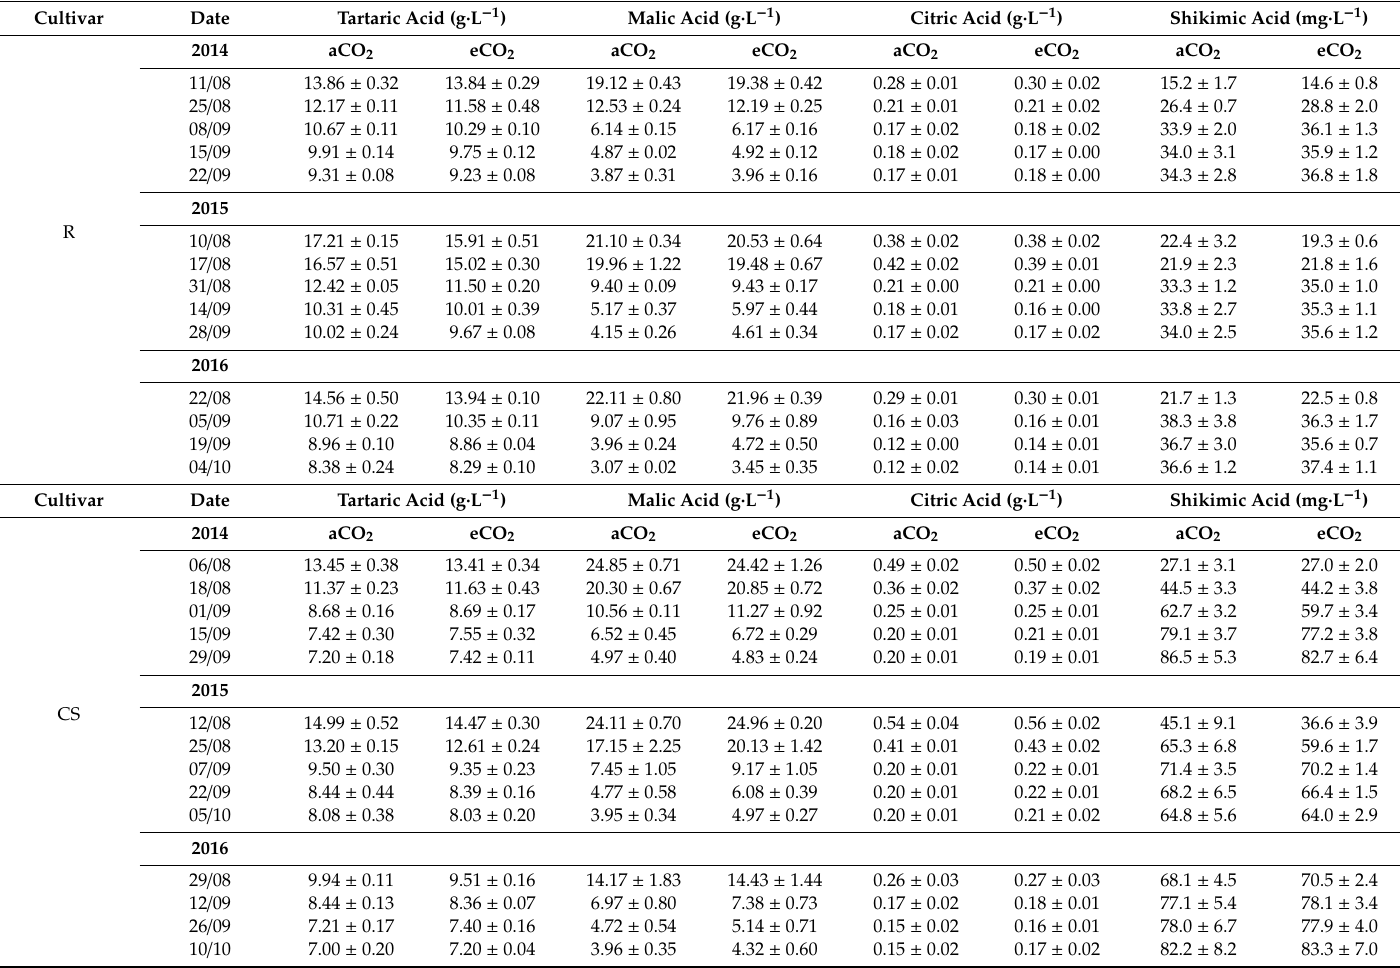
Table 2. Concentration of organic acids during ripening period of cvs. Riesling (R) and Cabernet Sauvignon (CS) under two CO 2 treatments and three seasons. Cultivar